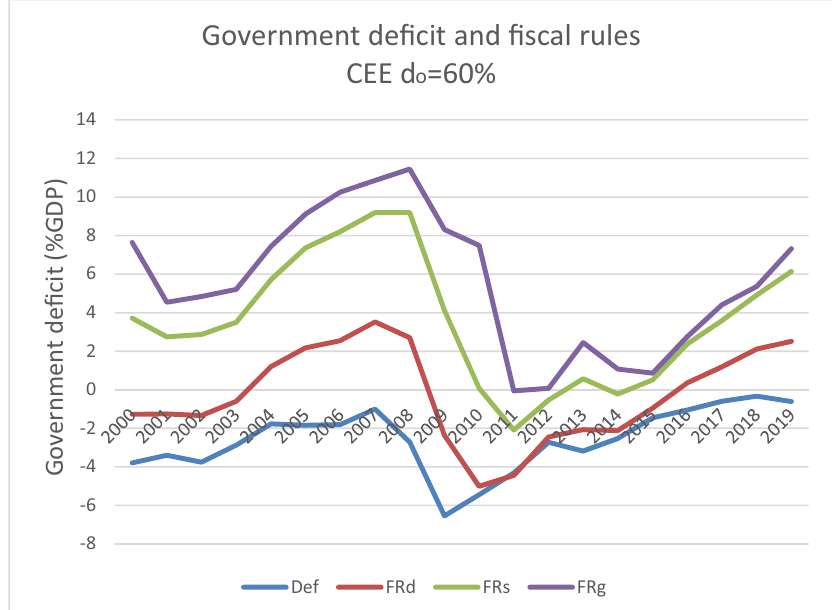
Figure 2.5: CEE countries government de fi cit ( Source: Own elaboration from data on Table 2 )